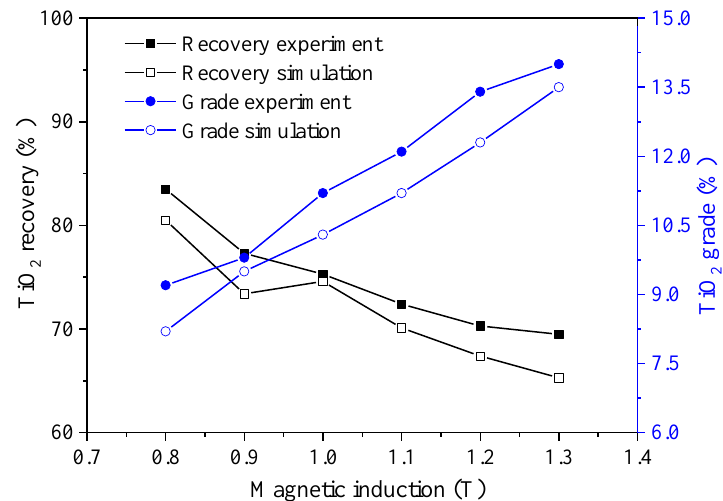
Figure 7. Effect of magnetic induction on separation performance.